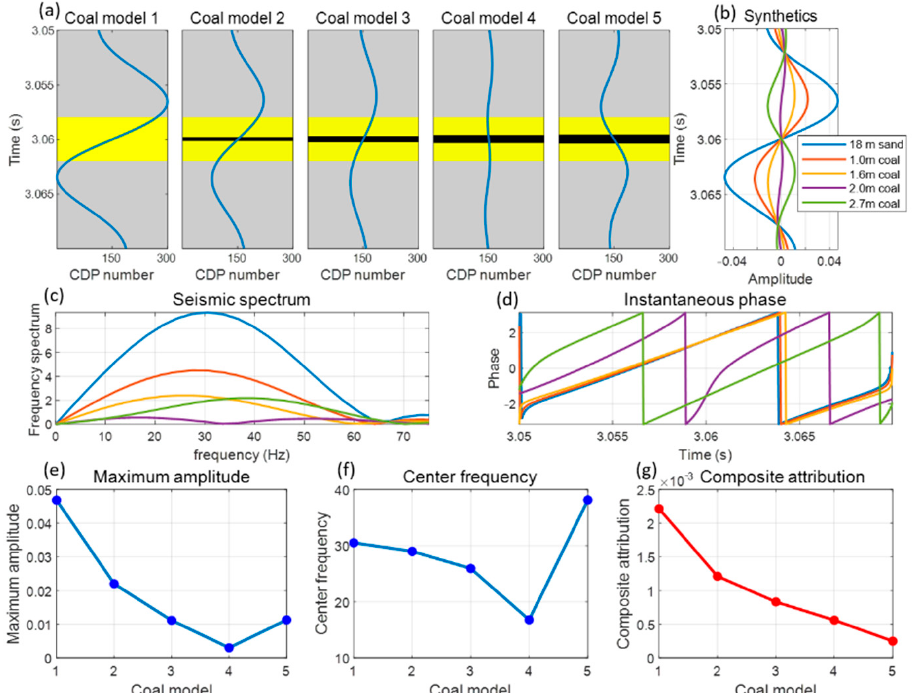
Figure 5. Model of thin coal seams coupled with sandstone and its synthetics and attributes: ( a ) coal model, ( b ) synthetic, ( c ) seismic frequency spectrum, ( d ) instantaneous phase, ( e ) maximum ampli- tude, ( f ) centre frequency, and ( g ) composite attribute.